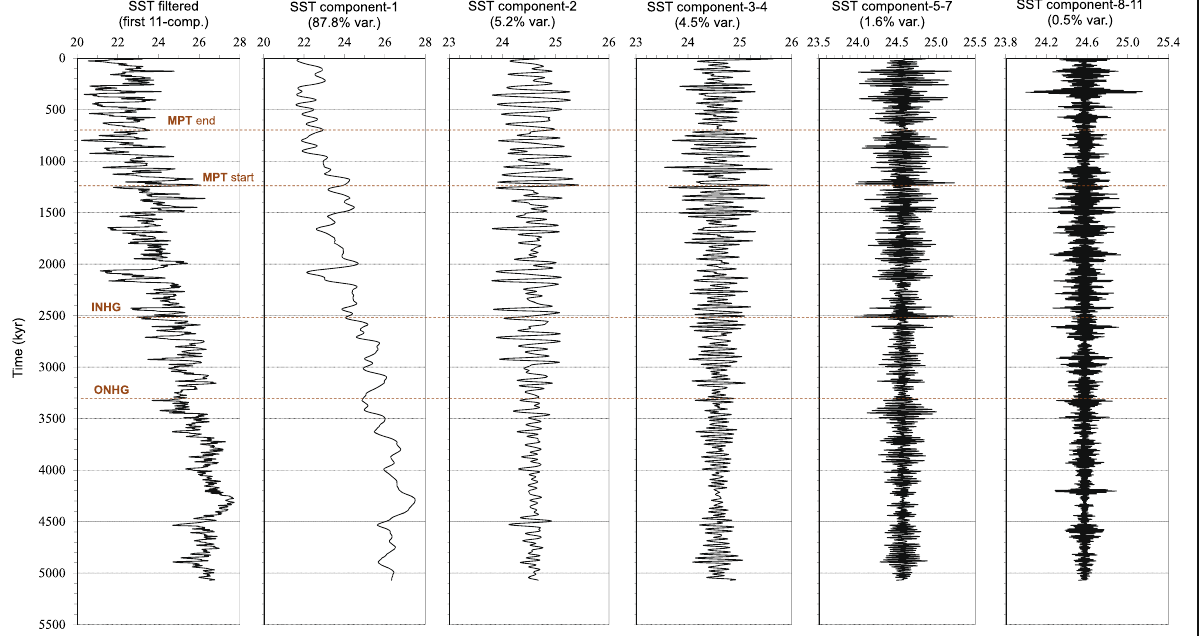
Fig. 5 Time-series panel of the five SST components isolated from the ODP Site 846 record by singular spectrum analysis with the SST-filtered record (left) obtained by combining these data components (99.6% total variance). The x -axis scale (°C) is variable in relation to the component ’ s variance fraction. Original SST data from Herbert et al. (2010b) resampled at 1 kyr. Time scale in